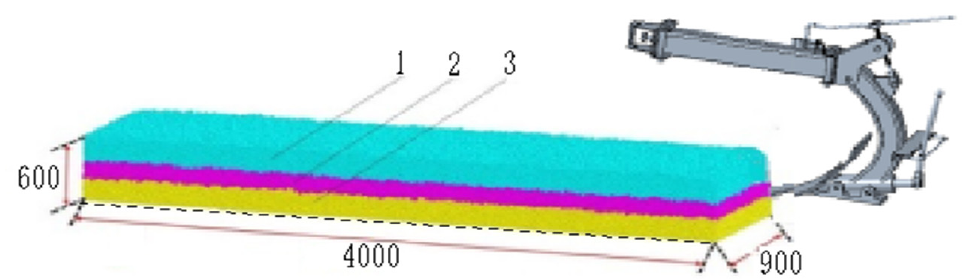
Figure 6. Simulation of the soil groove and ditching device geometric model. 1. Plough layer soil; 2. Plow sole; 3.